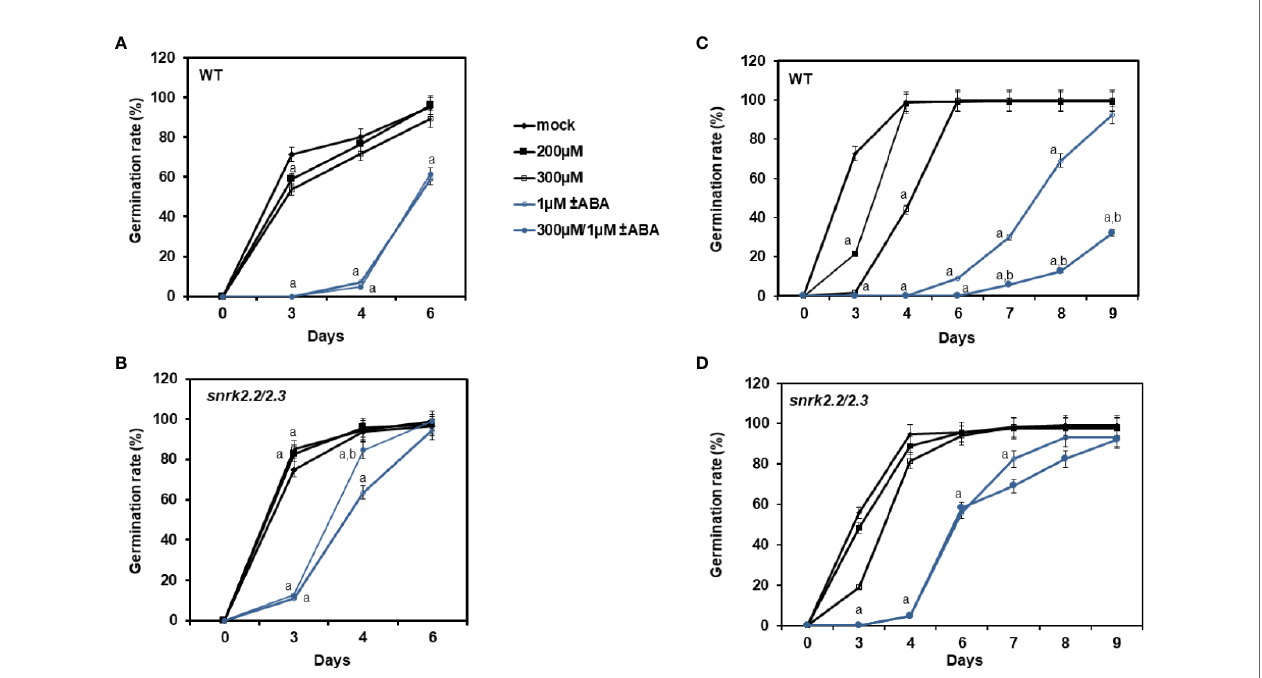
FIGURE 8 | Effect of ZINC59151964, ZINC05273880 and ABA on seed germination. Seeds of WT (A, C) , and snrk2.2/2.3 (B, D) mutant lines were grown on MS medium supplemented with ABA, the indicated concentration of ZINC compound or both. Right panel (A, B) presents germination results for ZINC59151964. Left panel (C, D) presents germination results for ZINC05273880. Seeds are considered germinated when green cotyledons have expanded. Values are the mean germination frequency from three to four separate plates (22 – 32 seeds per plate) for each genotype. Error bars indicate SD; “ a ” indicates a signi fi cant change ( P <